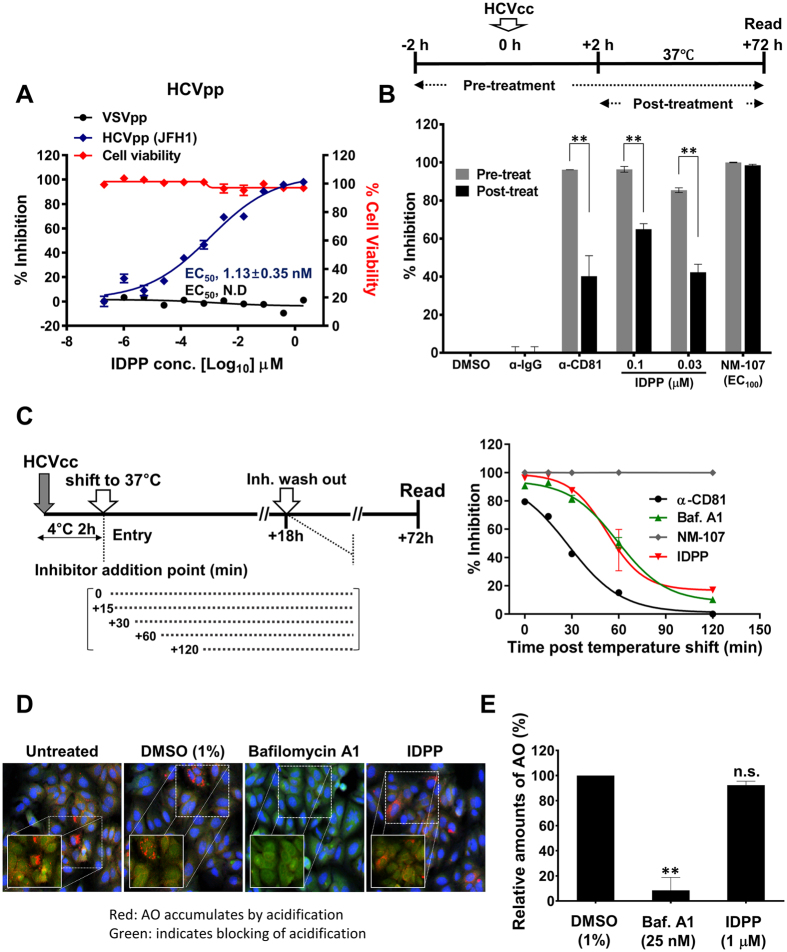
Inhibitory effects of IDPP on HCV entry.(A) Evaluation of IDPPs antiviral activity using HCV pseudoparticles (HCVpps). Transduction rates and percentage of inhibition were determined with HCVpp (JFH1) and VSVpp in the presence of IDPP. The means ± SD of duplicate experiments are shown. N.D = not determined. (B) Huh-7.5 cells were treated for 2 h with inhibitors before HCVcc infection (gray bars), or were treated for 2 h post-infection (black bars). At 72 h p.i., percent inhibition was calculated. Data represent means ± SD. **p < 0.01. (C) A Time-of-addition assay was performed as illustrated (detailed description in supplement). Data represent the mean ± SD of two independent assays in duplicate. (D) Evaluation of endosomal acidification by acridine orange staining. Images were acquired by confocal microscopy at 200X. (E) Quantification of endosomal acidification. Data are presented as the mean ± SD of two independent experiments. **p < 0.01; not significant (n.s.).